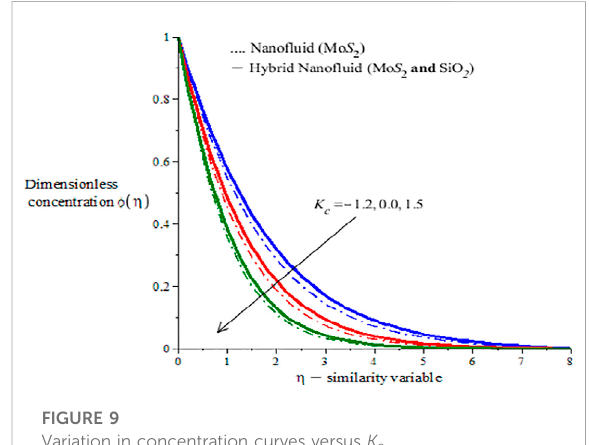
FIGURE 9 Variation in concentration curves versus K c